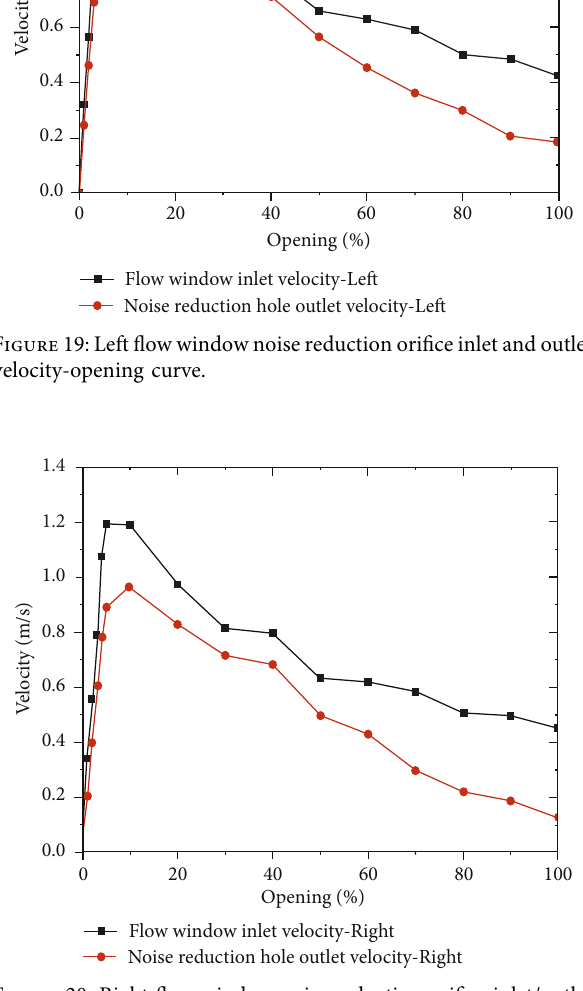
Figure 20: Right flow window noise reduction orifice inlet/outlet velocity-opening